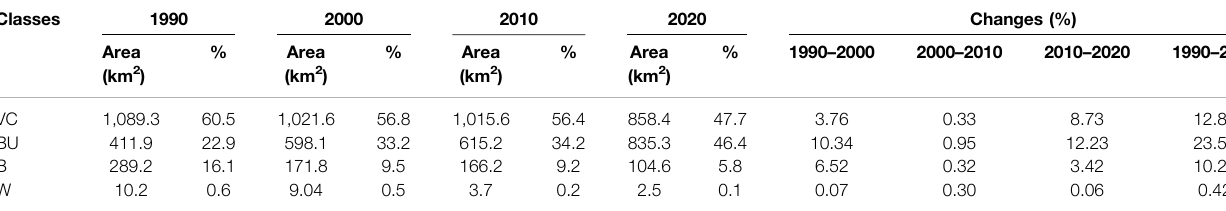
TABLE 3 | Statistics of LULC of Lahore for the years 1990, 2000, 2010, and 2020.